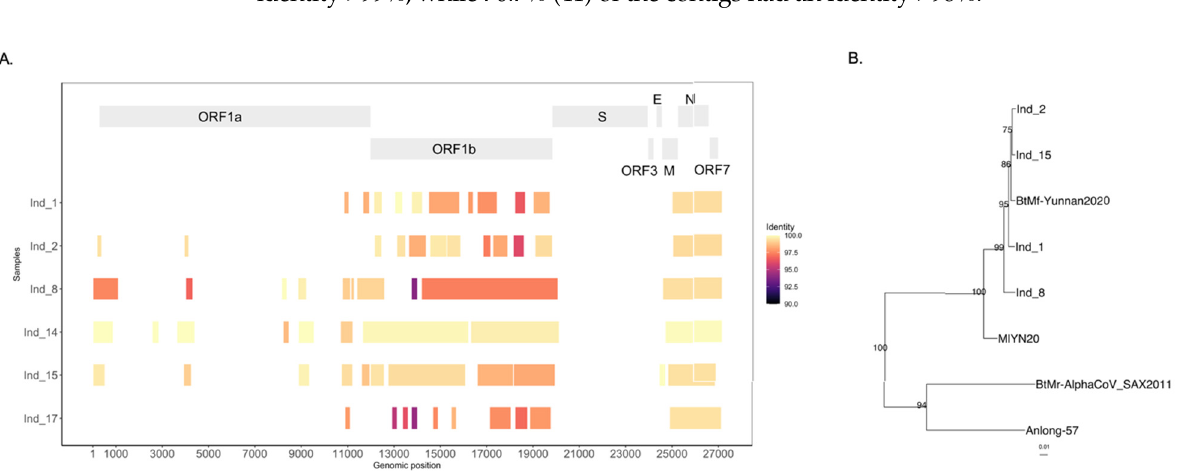
Figure 9. Inter-host diversity of the BtMf-Yunnan2020 genome. ( A ) Identity and breadth of coverage of BtMf-Yunnan2020 sequences in six individuals of M. fimbriatus . ( B ) Expansion in the myotacovirus subclade of a phylogenetic tree inferred from a 5 kb region of alphacoronavirus ORF1b; four consensus sequences from individuals were included in this analysis; statistical support is in- dicated.